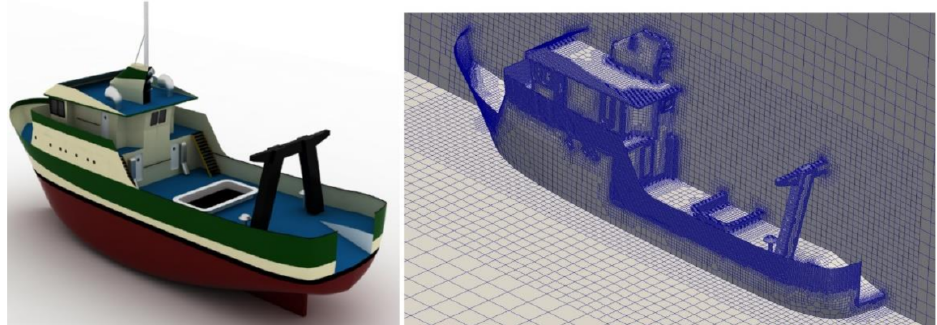
Figure 4. 3D model of the hull of a fishing vessel B-410 class ( left ) and a numerical grid ( right ). The 3D model of the examined fishing vessel and the vessel with the superimposed elements are shown in Figure 5.